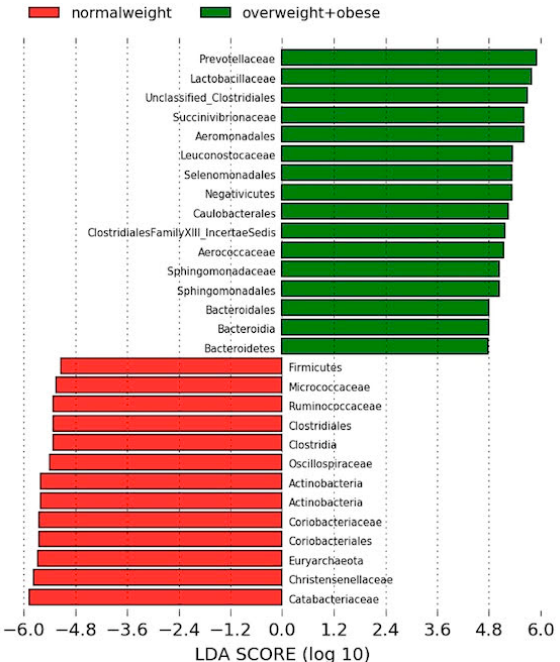
Figure 1. Linear discriminant analysis effect size between normal weight and overweight+obese subjects. Red, bacterial taxa statistically overrepresented in normal weight participants; green, bacterial taxa overrepresented in overweight and obese volunteers.